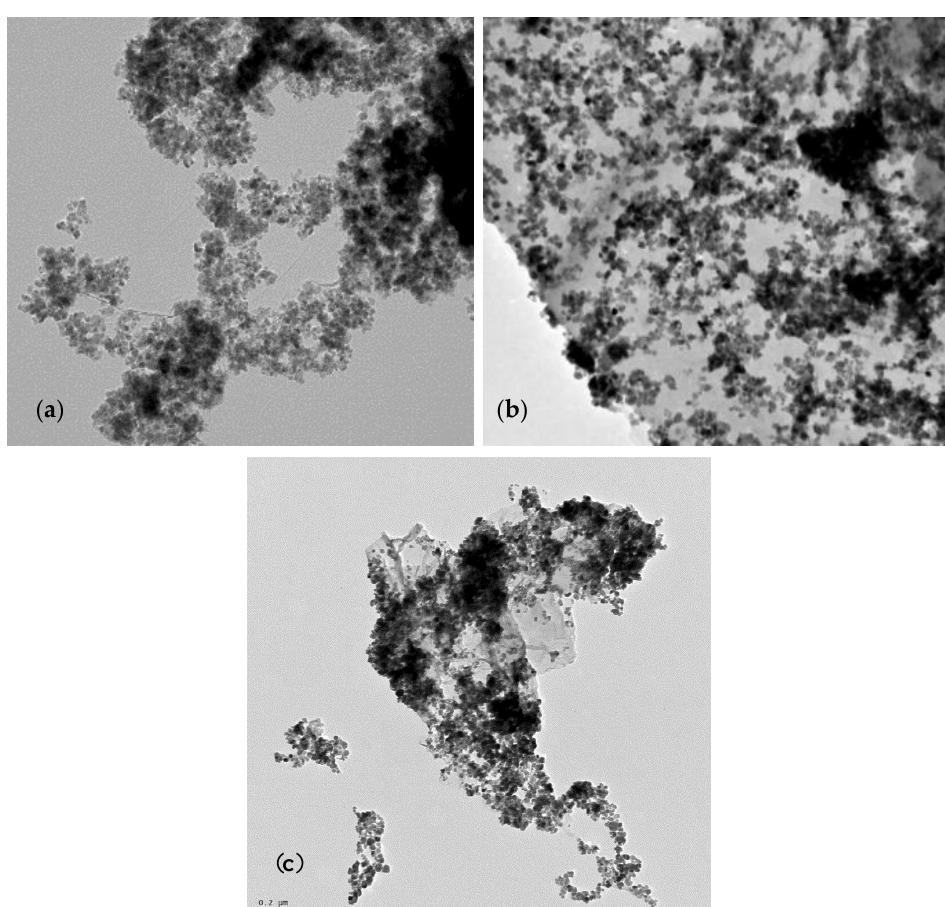
Figure 5. TEM images of materials synthesized by ( a ) Method 1 (1-PSTH), ( b ) Method 2 (2-PSTH) and ( c ) Method 3 (3-PSTH), with a scale of 0.2 μm.